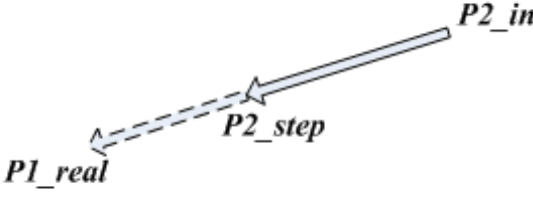
Figure 5. The sampling direction of a random tree growing at target point.